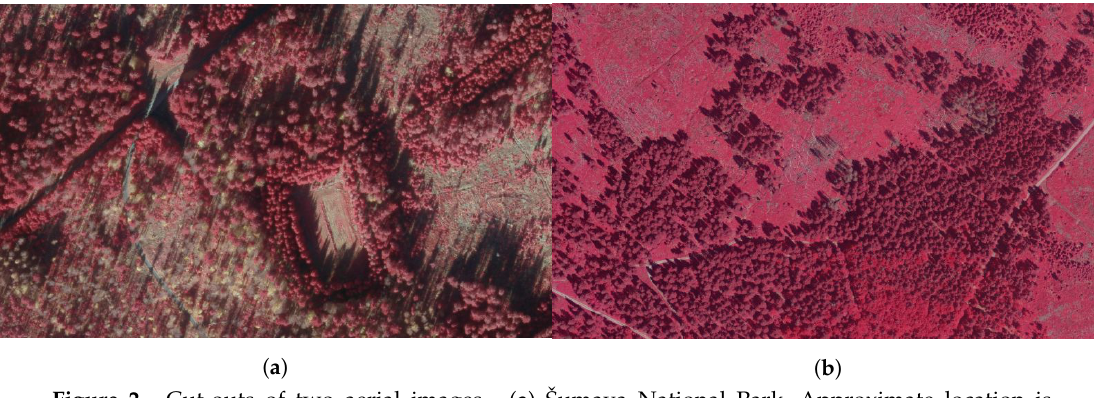
Figure 2. Cut-outs of two aerial images. ( a ) Šumava National Park. Approximate location is 49 ◦ 7.26 (cid:48) N, 13 ◦ 19.27 (cid:48) E. Approximate size is 514 m × 243 m. Note the spectral appearance of broadleaf trees due to fall foliage. ( b ) Bavarian Forest National Park. Approximate location is 49 ◦ 6 (cid:48) N, 13 ◦ 18.61 (cid:48) E. Approximate size is 624 m × 377